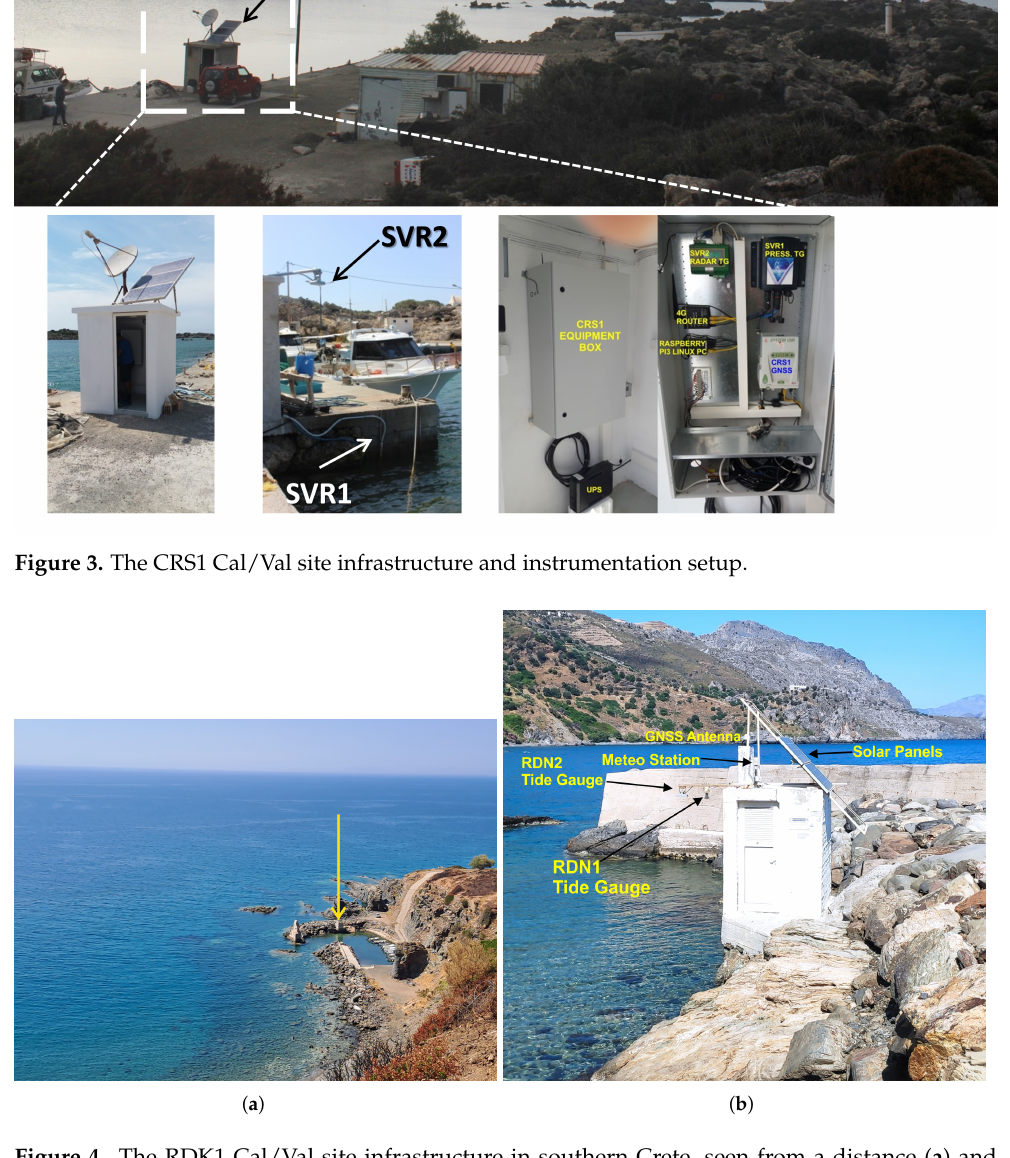
Figure 4. The RDK1 Cal/Val site infrastructure in southern Crete, seen from a distance ( a ) and closer ( b